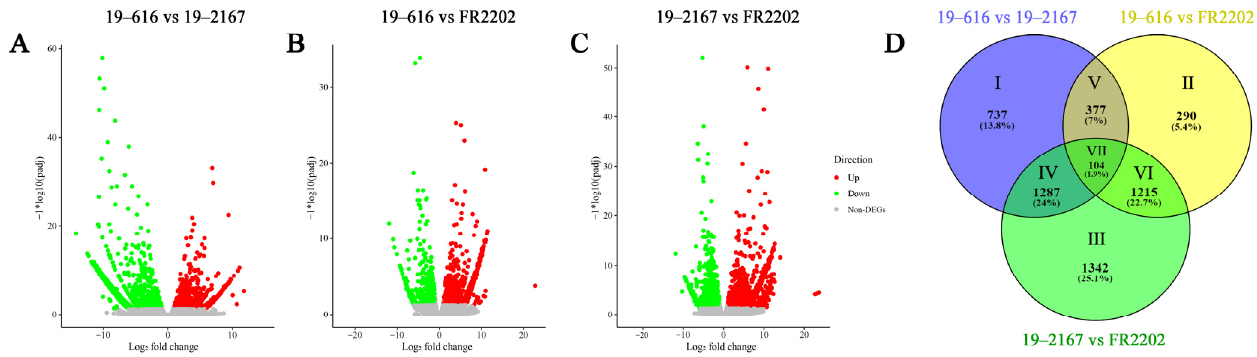
Figure 3. Di ff erential expression analysis of nuclear genes. ( A – C ) The pairwise comparison between 19–616, 19–2167 and FR2202. ( D ) Analysis of the shared DEGs in 19–616, 19–2167 and